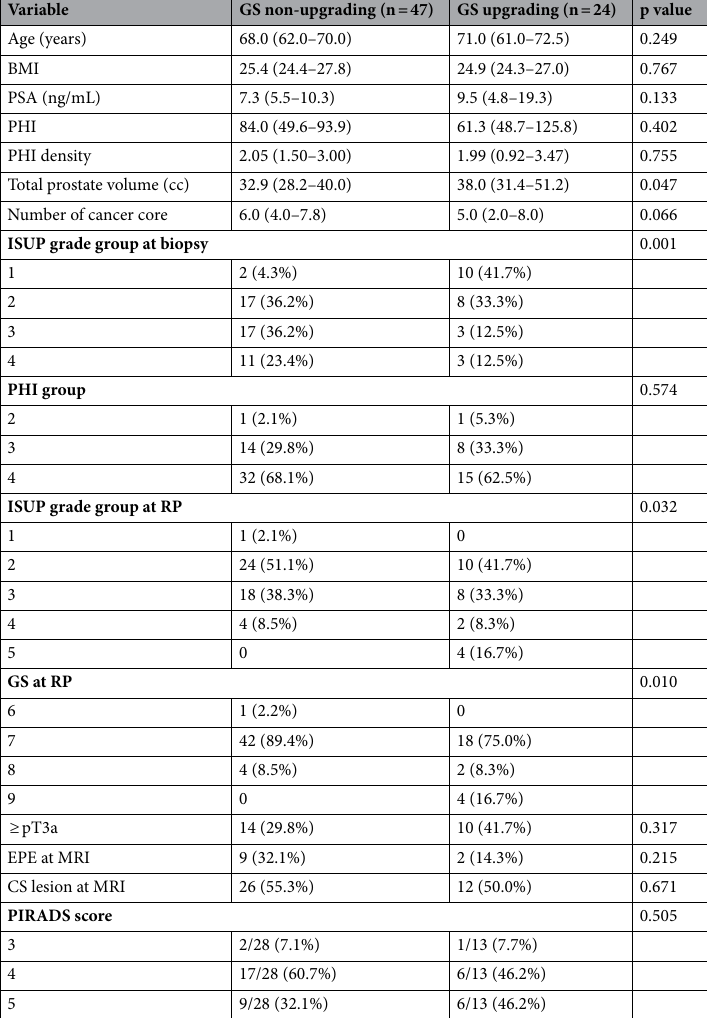
Table 1. Baseline characteristics according to Gleason score (GS) upgrading in RP specimens. Values are presented as median (interquartile range) or number (%). BMI body mass index, CS lesion: clinically significant PIRADS lesion, EPE extraprostatic extension, GS Gleason score, ISUP International Society of Urological Pathology, MRI magnetic resonance imaging, PHI prostate health index, PIRADS prostate imaging reporting and data system, PSA prostate-specific antigen, RP radical